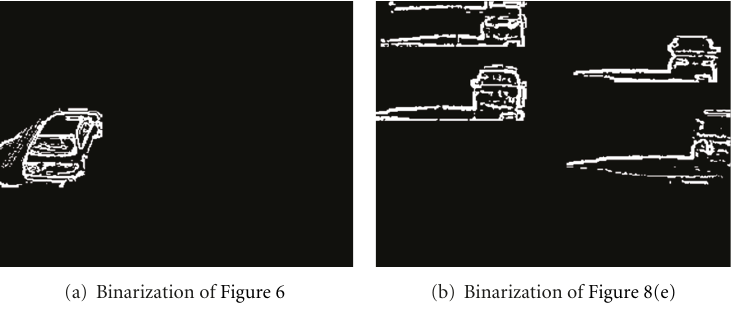
Figure 9: Examples of BinI MBR